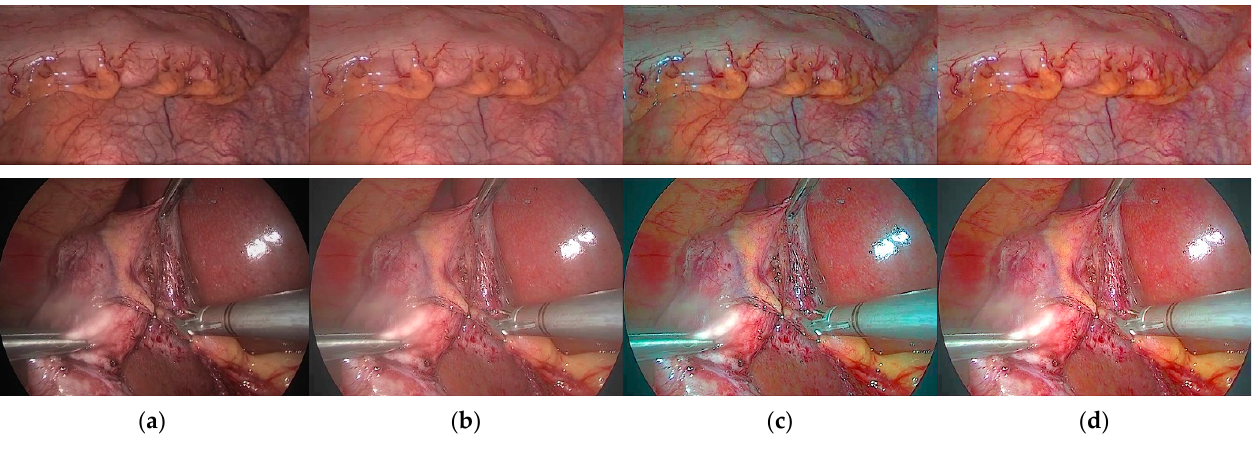
Figure 13. Results of comparison with and without reflection component enhancement. ( a ) Original image; ( b ) Result without reflection component enhancement; ( c ) Result of stretching all three channels of the reflective component; ( d ) G and B channels of the reflectance component are adaptively stretched, and the R channel remains unchanged.